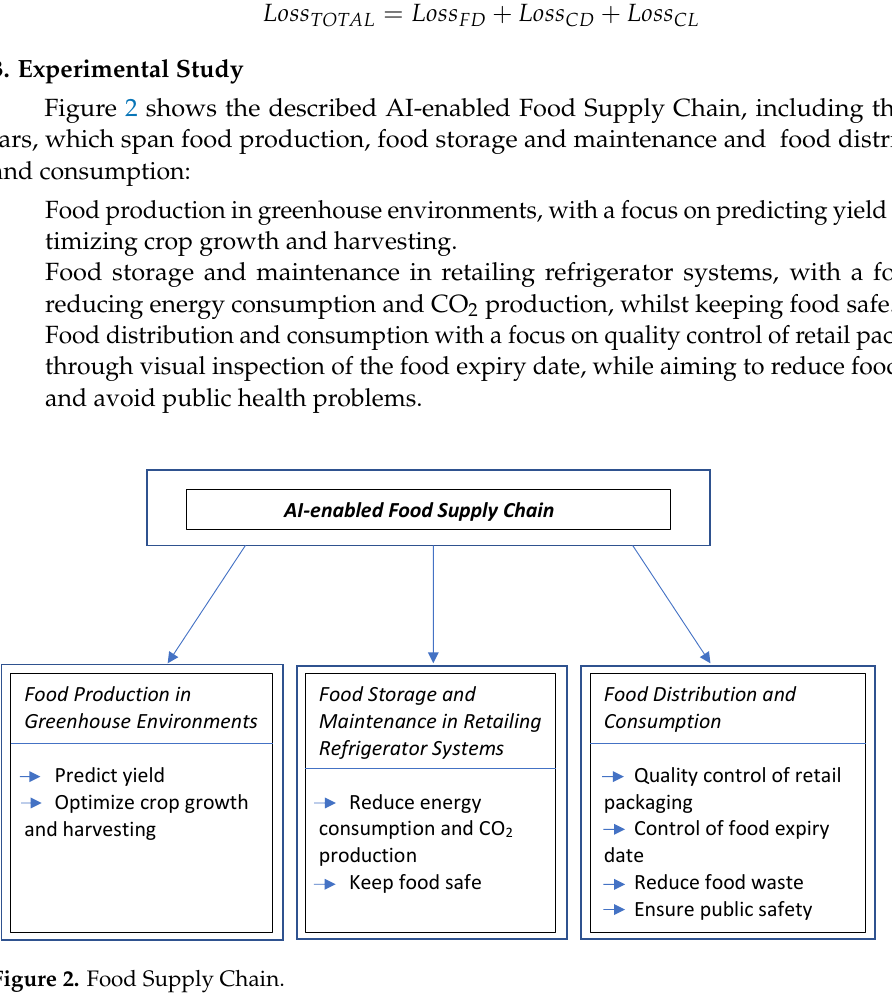
Figure 2. Food Supply